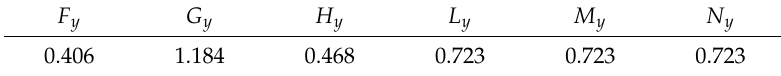
Table 4. Anisotropic parameters in the Hill yield function for rolled AZ31 alloys. F